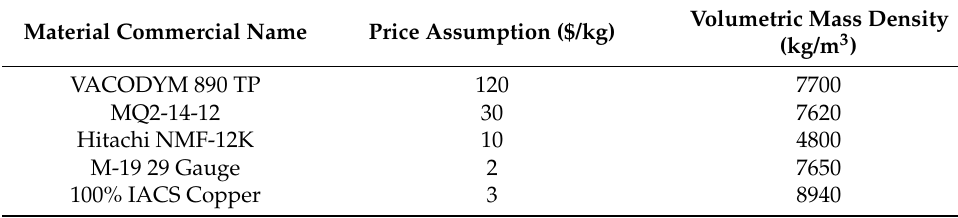
Table 10. Active material prices and volumetric mass